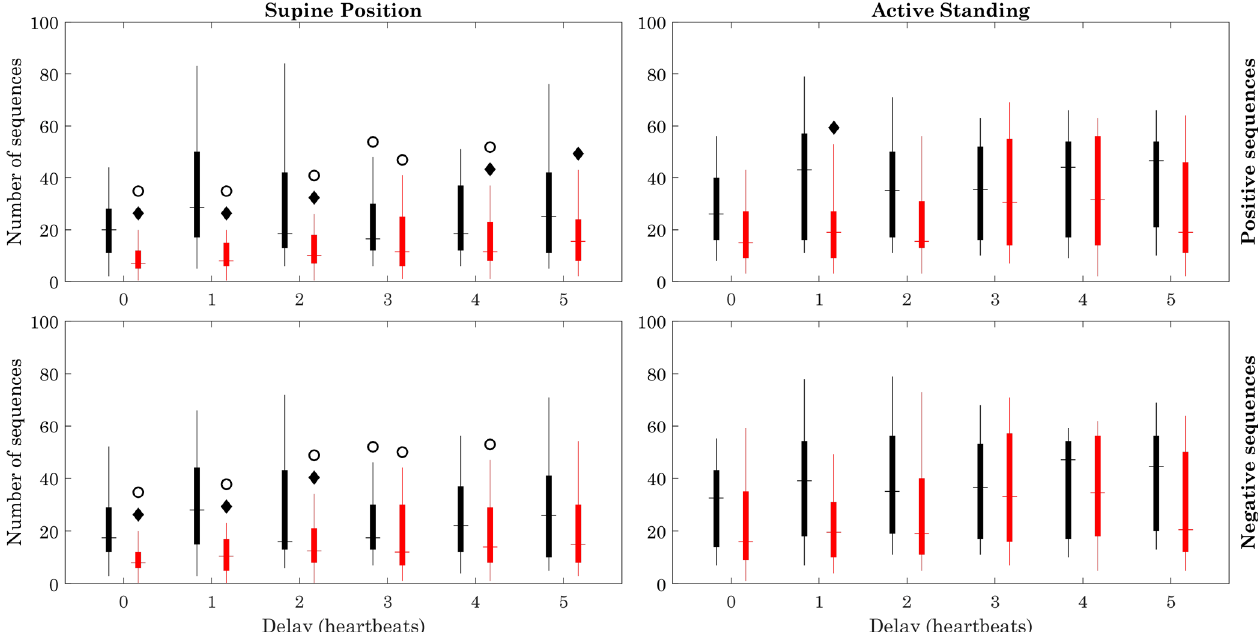
Figure 5. Number of sequences. Figure symbology: Healthy subjects (black), ESRD patients (red). Open circle: Supine Position vs. Active Standing (within same group), p < 0.05. Black diamond: ESRD vs. Healthy group (within same position), p < 0.05.